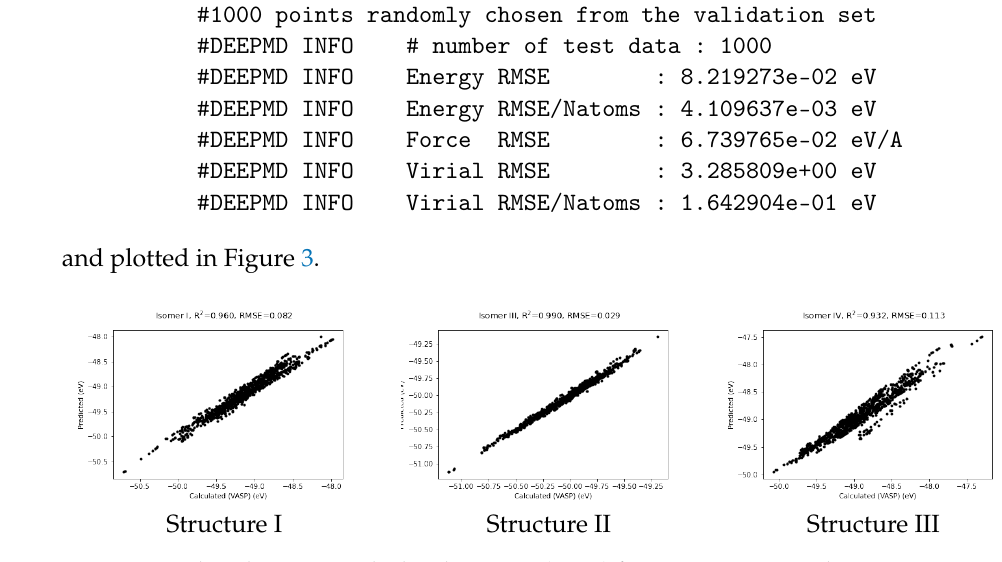
Figure 3. Predicted vs VASP-calculated energies (in eV) for structures I, II and